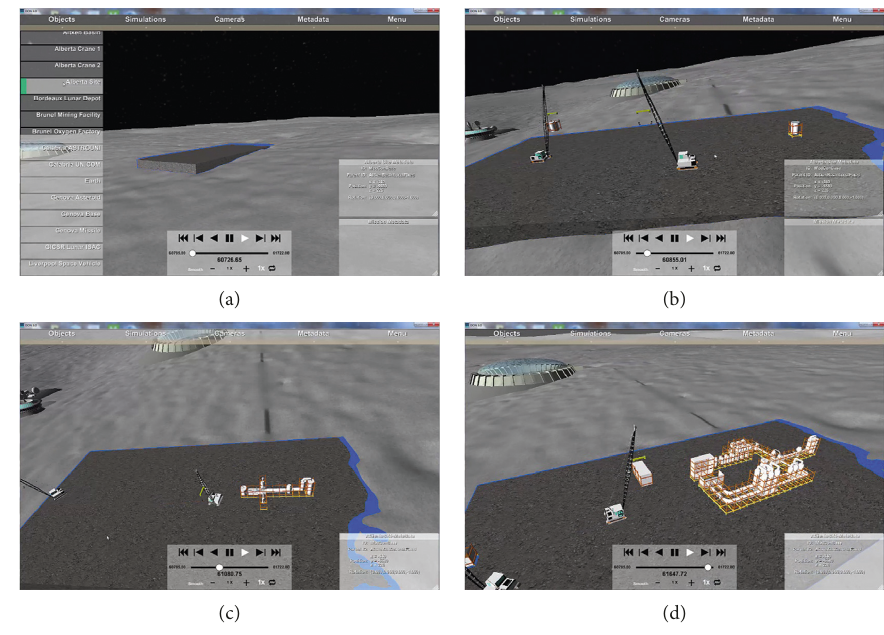
Figure 2: Erecting water treatment facility on the moon surface as rendered by DON. Table 1: A summary of the characteristics of three developed visualization